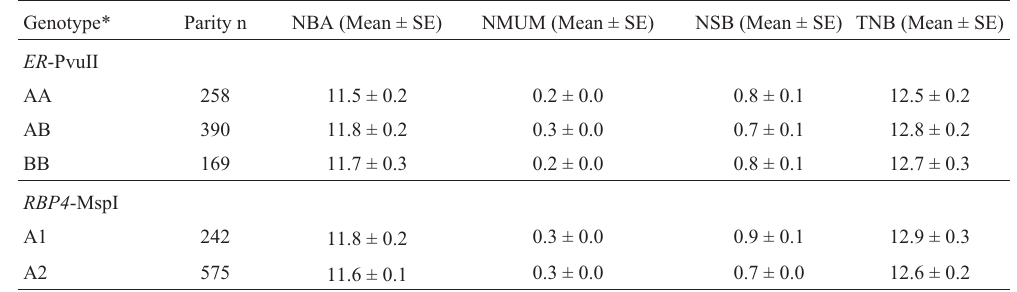
Table 1 - Association of estrogen receptor ( ER -PvuII) and retinol-binding protein 4 ( RBP4 -MspI) genotypes with mean number of piglets born alive (NBA), number of mummies (NMUM), number of stillborn piglets (NSB), and total number born (TNB) per litter in the four parities.